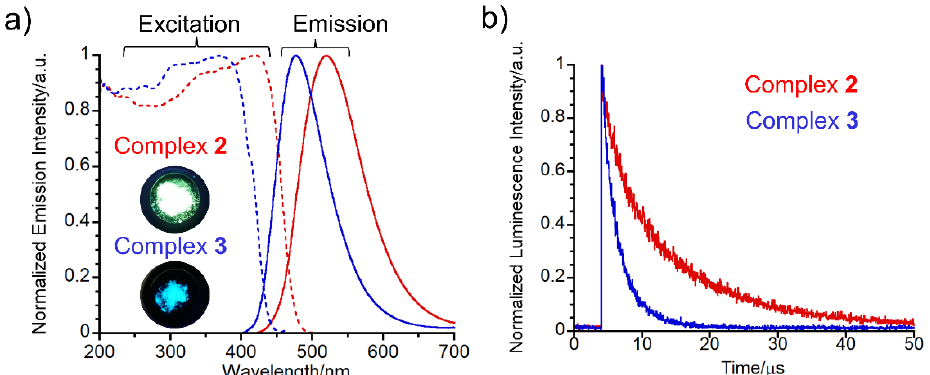
Figure 3. ( a ) Emission (solid lines, excited at 380 nm) and excitation (dashed lines, observed at 519 nm for 2 and 478 nm for 3 ) spectra of 2 (red lines) and 3 (blue lines) in the solid state at room temperature. Photographs of 2 (top) and 3 (bottom) under 365 nm light irradiation. ( b ) Transient luminescence decay curves of 2 and 3 at room temperature.